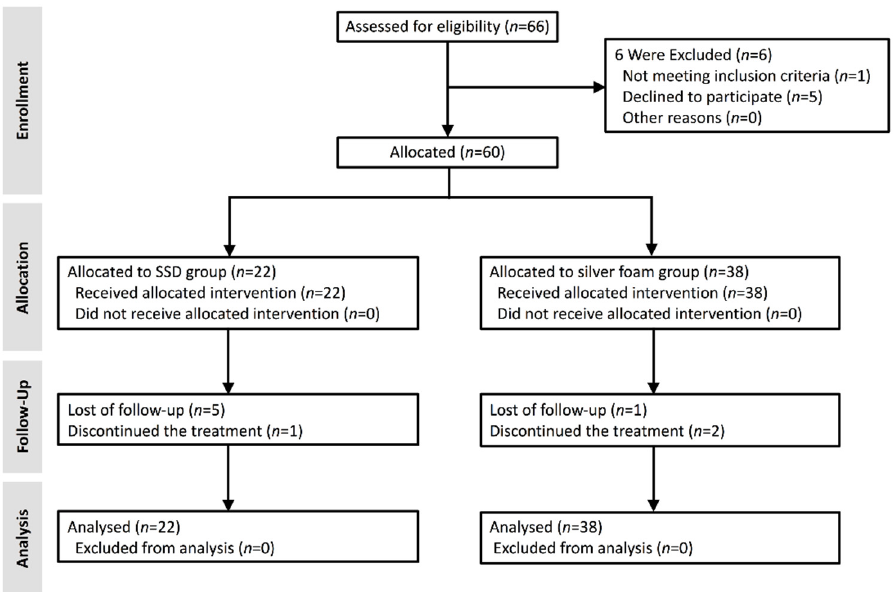
Figure 1. CONSORT flow diagram of the study. Six of the 66 diabetic foot ulcer (DFU) patients were excluded from the trial and 60 patients were included. Of the 22 participants in the 1% silver sulfadiazine (SSD) group who were included in the analysis 1 patient stopped the treatment, and 5 patients were lost to follow-up. Of the 38 participants in the silver foam group, all 38 were included in the analysis, 2 patients discontinued the treatment, and 1 patient was lost to follow-up.